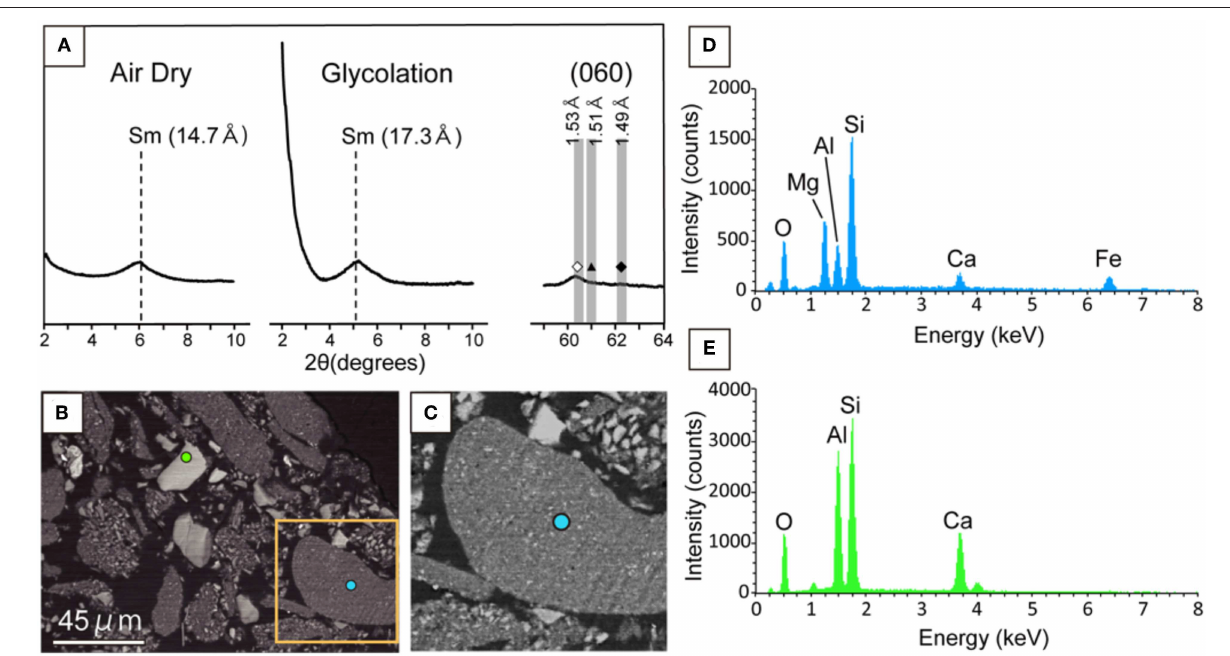
FIGURE 3 | Mineralogical characterization of the clay fraction separated from a powdered core sample in U1365E-7R2. (A) Low-angle XRD patterns (2 θ : 2–10 ◦ ) from air-dried and ethylene-glycolated samples vertically oriented to the c-axis of phyllosilicate minerals (left and middle). High angle XRD pattern (2 θ : 59–64 ◦ ) including 060 reflections from the randomly oriented sample (right). Sm indicates smectite. In the high-angle XRD pattern, vertical bands show 2 θ ranges of 060 reflections from trioctahedral phyllosilicate minerals (left with open diamond), nontronite and celadonite (middle with filled triangle), and dioctahedral phyllosilicate minerals (right with filled diamond; Moslehuddin and Egashira, 1997). (B) Back-scattered electron image of the clay fraction with light blue and light green circles, from which EDS spectra were obtained for the low-contrast phase and the high contrast phase (D,E) . An orange rectangle indicates an enlarged area shown in (C) . (C) Back-scattered electron image of the enlarged area in (B) . (D) EDS spectra from light blue and light green circles in (B)